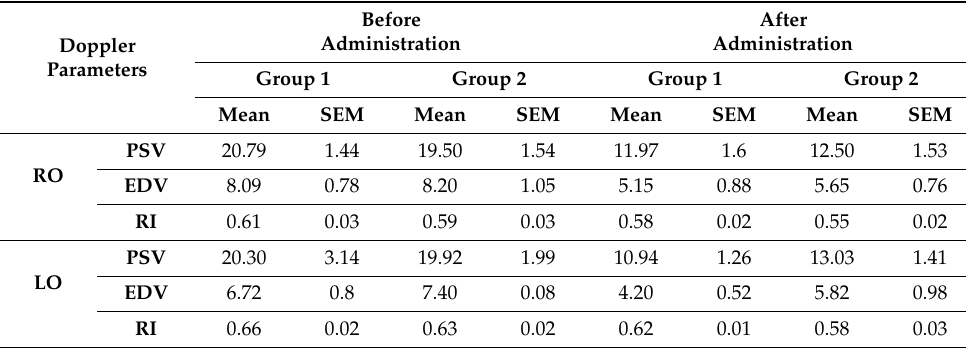
Table 1. Group 1 and 2 before and after sedation ( n = 10 for each group).